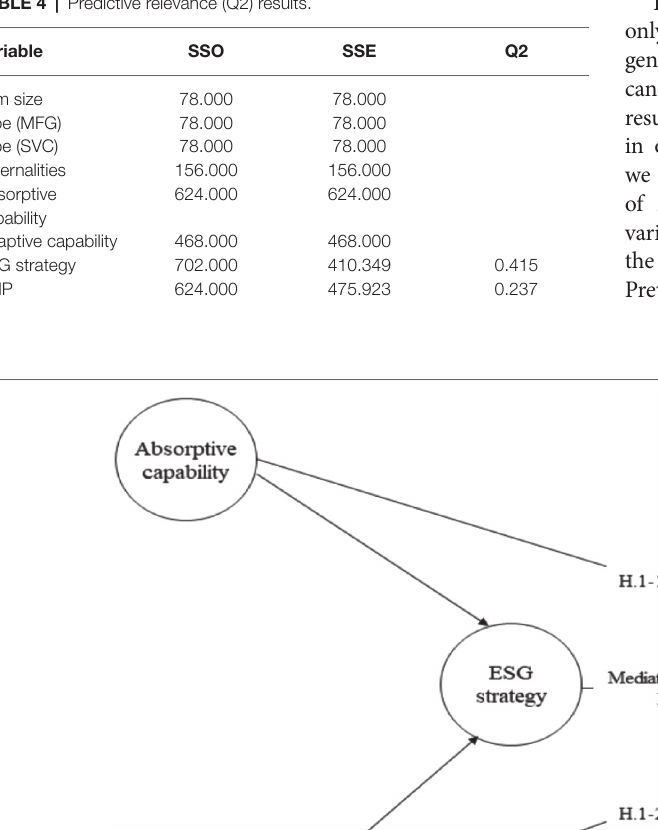
TABLE 4 | Predictive relevance (Q2) results.